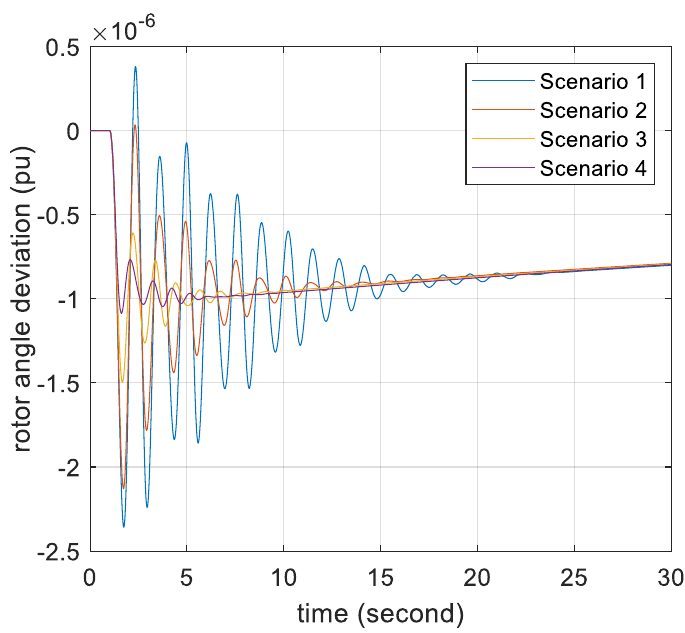
Figure 6. Rotor speed responses of G3.